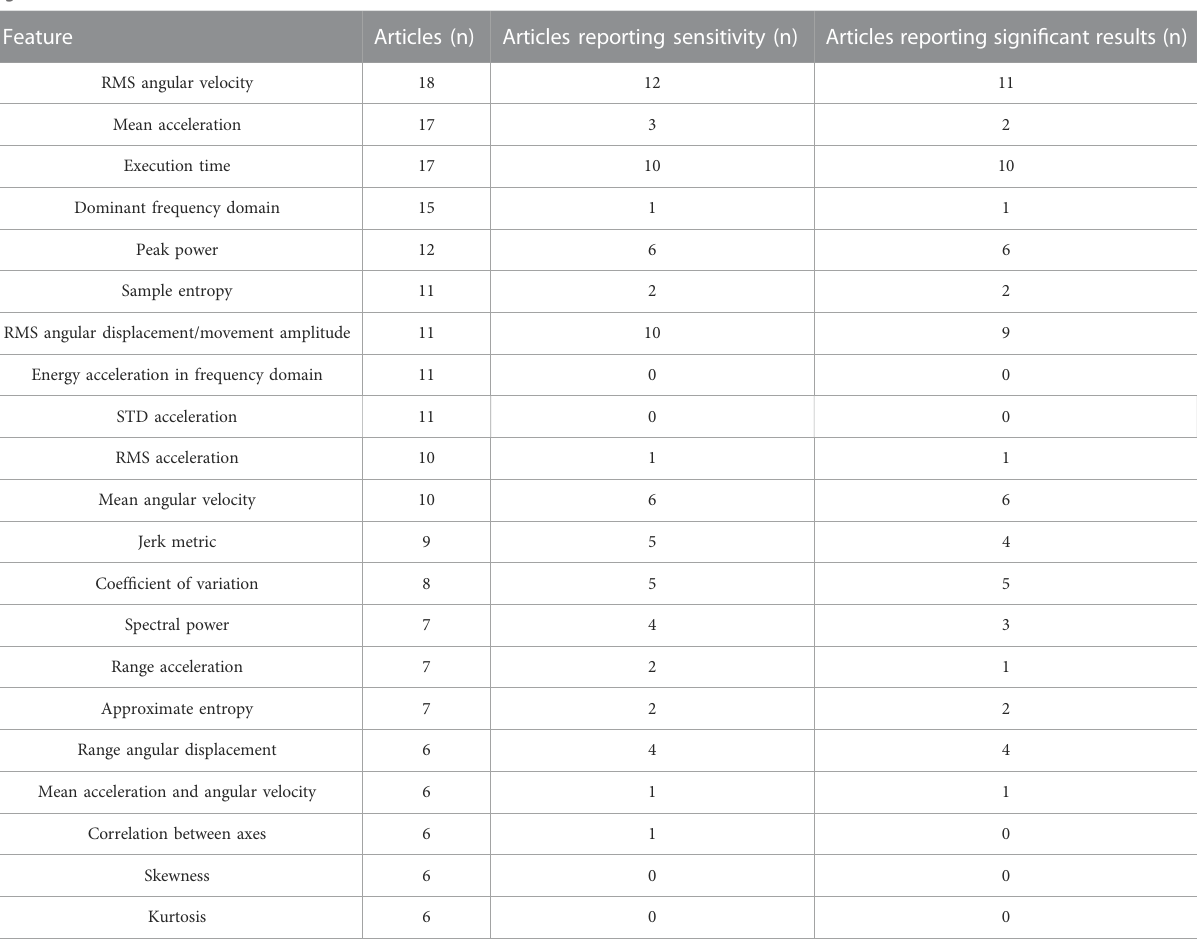
TABLE 3 Most prevalent features, the number of articles they appear in, the number of articles reporting sensitivity and the number of articles reporting signi fi cant